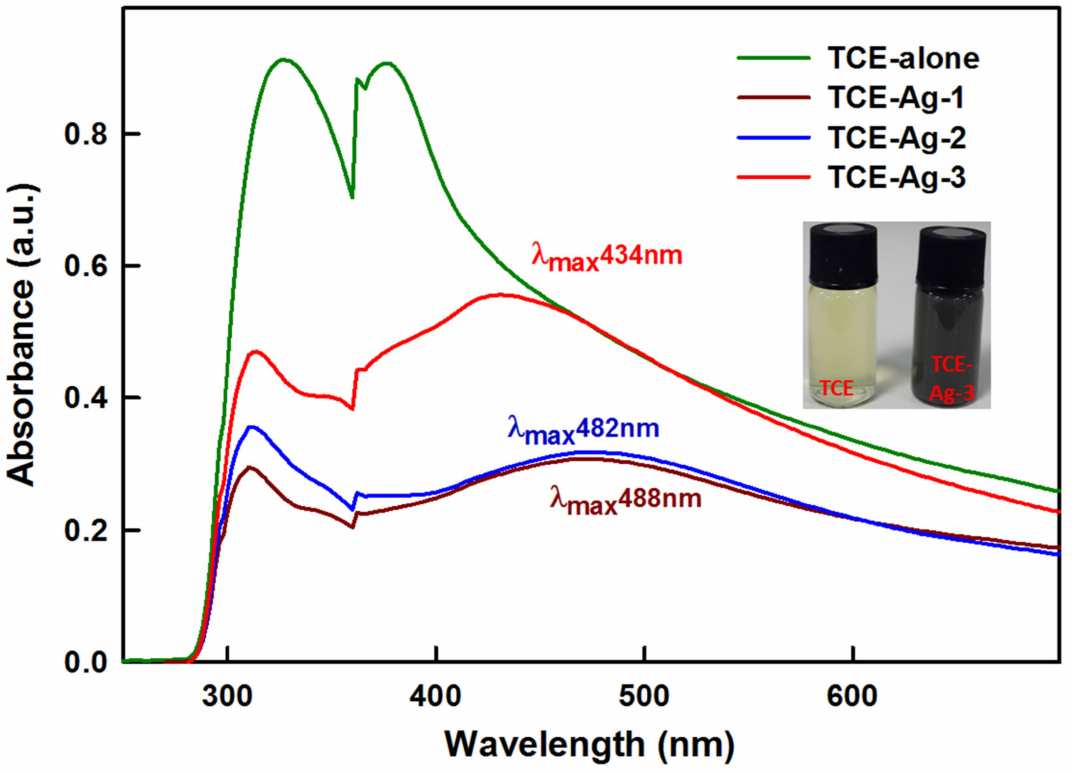
Figure 1. UV–vis analysis of synthesized TCE-Ag-NPs. The inset demonstrates the change in color of the reaction mixture from light yellow to dark brown nano Ag colloidal